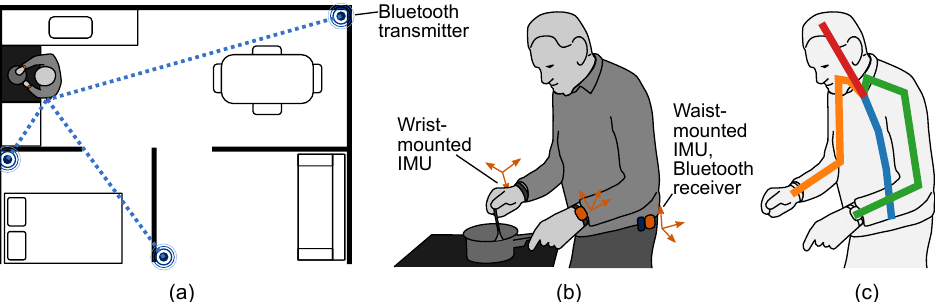
Figure 1. Overview of our strategy for in-home localization and kinematics monitoring. ( a ) In-home localization approach. Bluetooth transmitters are installed around the home, and the received signal strength is monitored at the patient. The localization provides context to the captured activities. ( b ) Minimal sensor set that is unobtrusive during daily life, including IMUs worn on each wrist and the waist, and a Bluetooth receiver worn at the waist. ( c ) Kinematic reconstruction of the torso derived from the worn